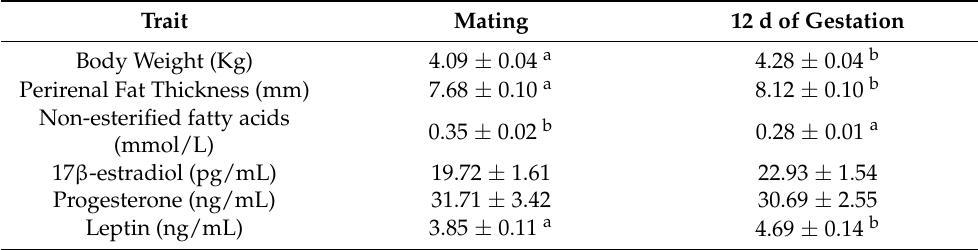
Table 2. Least square means and standard error of body weight, perirenal fat thickness, 17 β -estradiol, NEFA, progesterone and leptin at mating and 12 d of